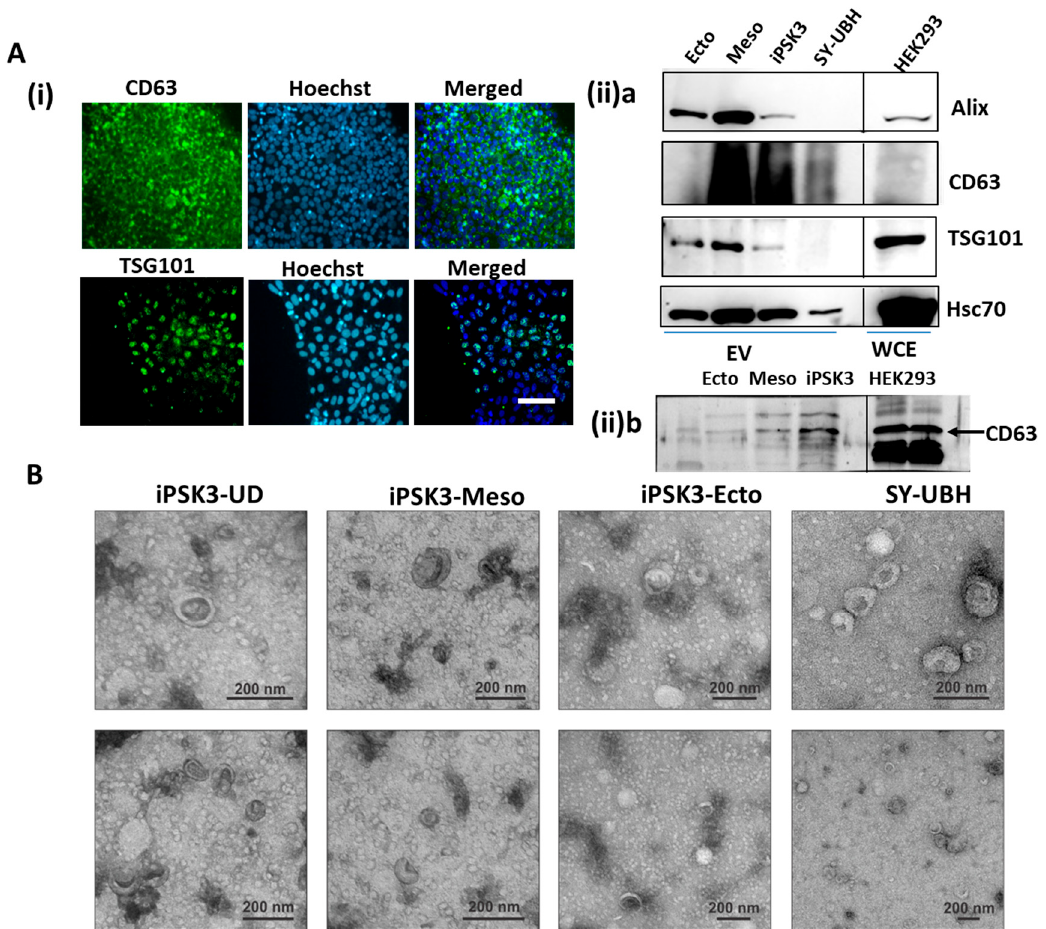
Figure 3. Characterization of hiPSC-derived EVs for exosomal markers and morphology. ( A ) (i) CD63 and TSG101 expression on undi ff erentiated iPSK3 cells; Scale bar: 100 µ m. (ii) a: Western blot analysis of Alix, CD63, TSG101, and Hsc70 for the derived EVs from di ff erent iPSK3 groups as well as the SY-UBH group. WCE: whole cell extracts. WCE from HEK293 cells was used as a positive control. b: Western blot analysis of CD63 for the derived EVs from di ff erent iPSK3 groups, showing distinct CD63 bands. ( B ) Presence of exosome-sized, cup-shaped vesicles was verified by electron microscopy (EM). Scale bar: 200